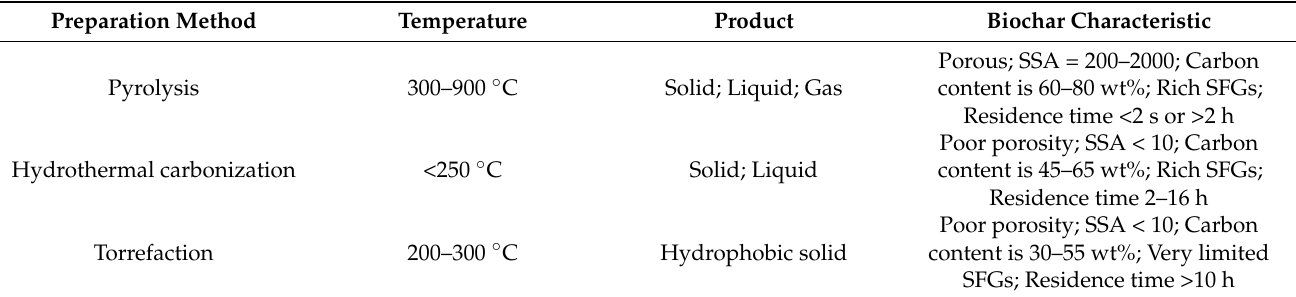
Table 1. Comparison of biochar preparation processes